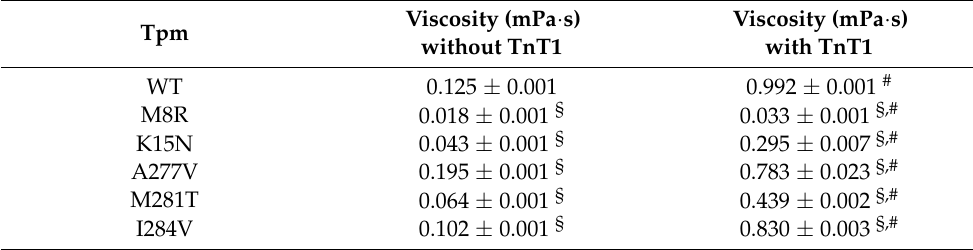
Table 2. Excess viscosities of Tpm mutants’ solutions in the presence or absence of TnT1 over buffer